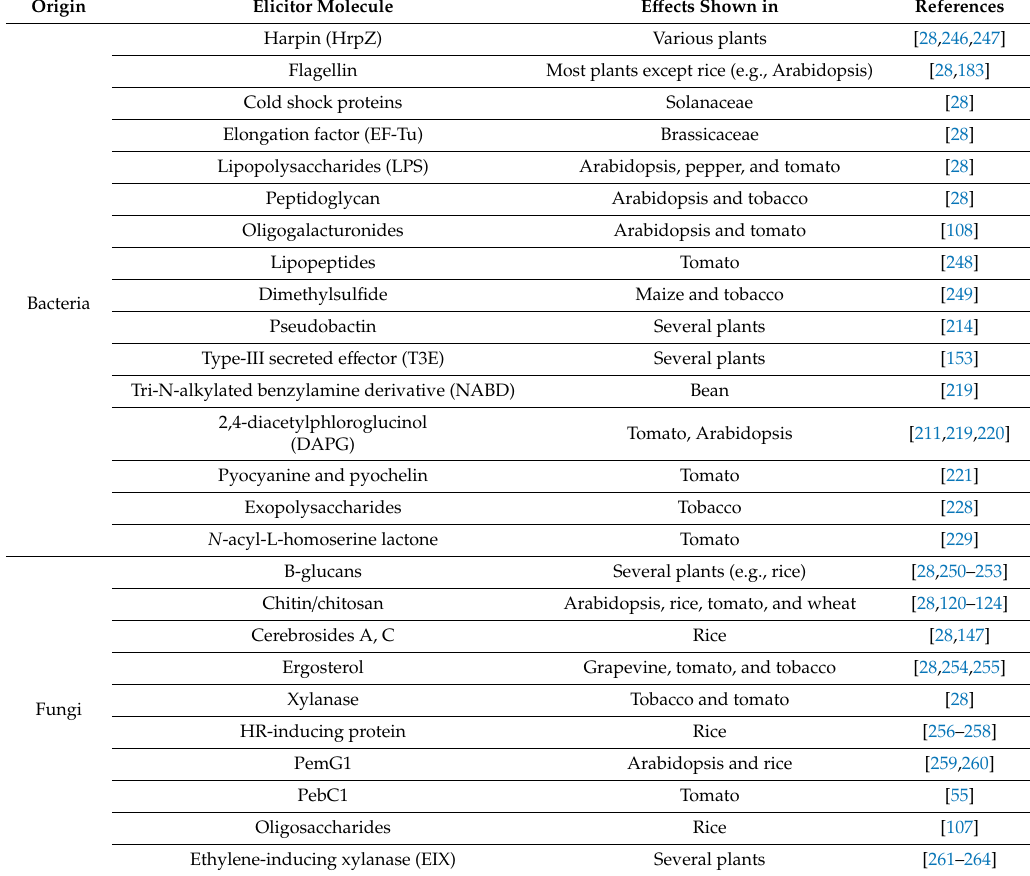
Table 1. List of identified elicitor molecules of biotic stress agents in bacteria, fungi, insect, and synthetic